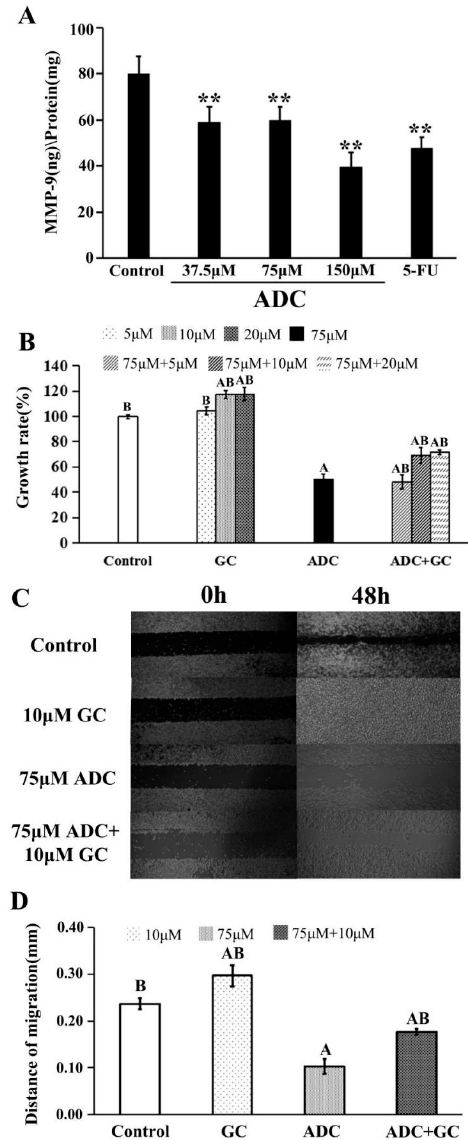
Figure 4. Effects of matrix metalloproteinase (MMP)-9 on the migration and proliferation of SPCA-1. ( A ) Expression of MMP-9 in SPCA-1 was detected by an ELISA kit after being treated with ADC for 72 h, and 5-FU was used as a positive control. ** p < 0.01 vs. control; ( B ) effects of MMP-9 activator (GC) on ADC-induced cell growth inhibition were detected by alamarBlue ® assay, A p < 0.01 vs. control, B p < 0.01 vs. 75 μ M ADC; ( C ) and ( D ) effects of the MMP-9 activator (GC) on ADC-induced cell migration inhibition were detected by microscope , A p < 0.01 vs. control, B p < 0.01 vs. 75 μ M ADC.